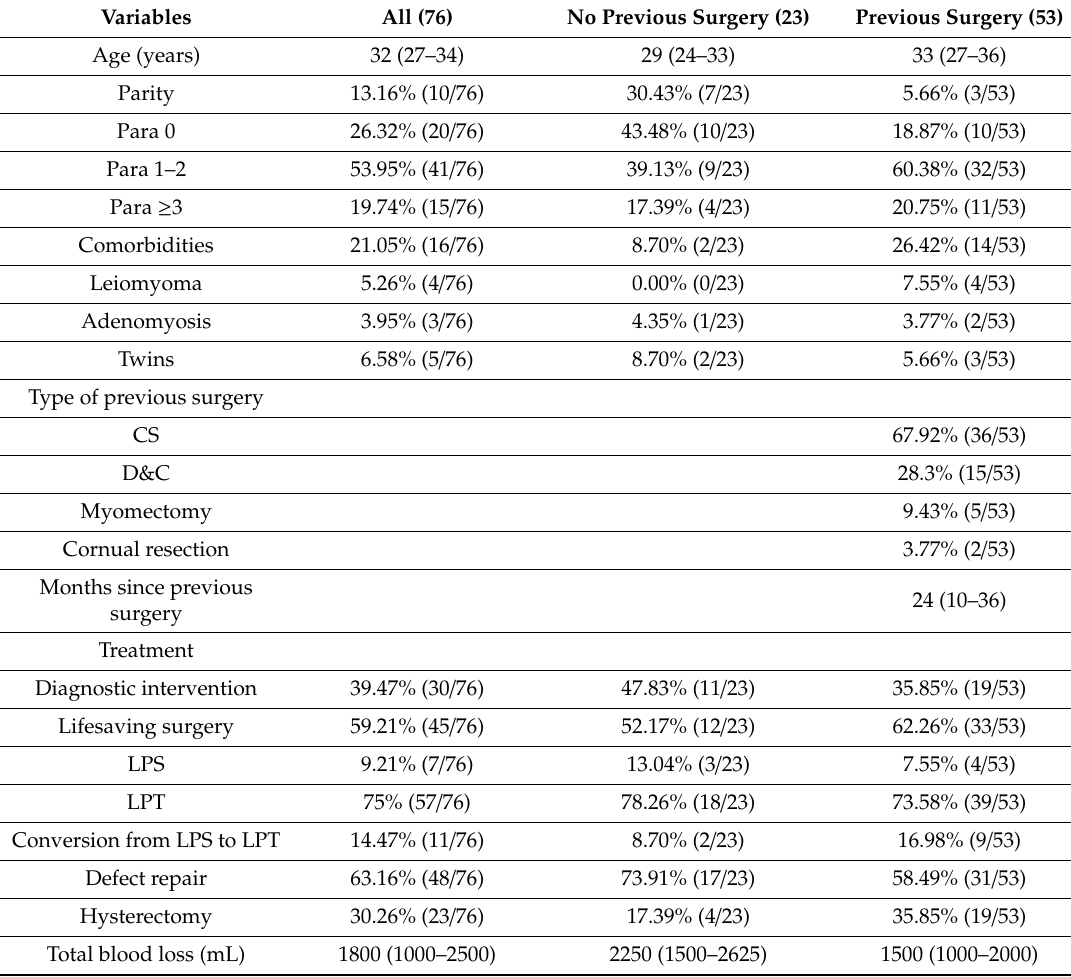
Table 1. Aggregated data of maternal features, previous surgery, and management of first-trimester uterine rupture cases from the systematic review of the literature.